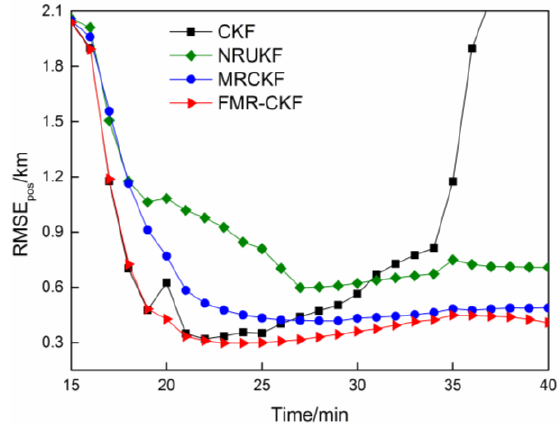
Figure 3. The RMSE pos comparison when outliers appear.